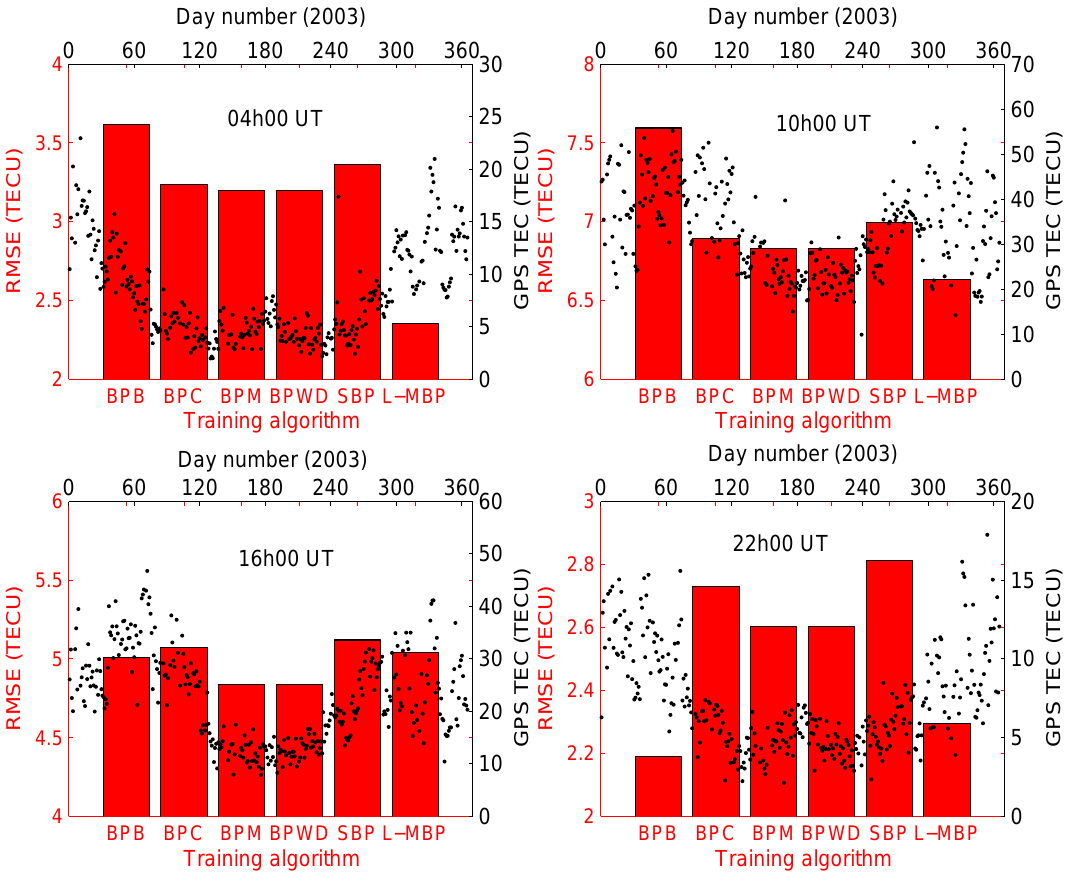
Fig. 2. GPS TEC values and RMSE values computed for modelled TEC using different algorithms at 04:00UT, 10:00UT, 16:00UT and 22:00UT, respectively, over SUTH